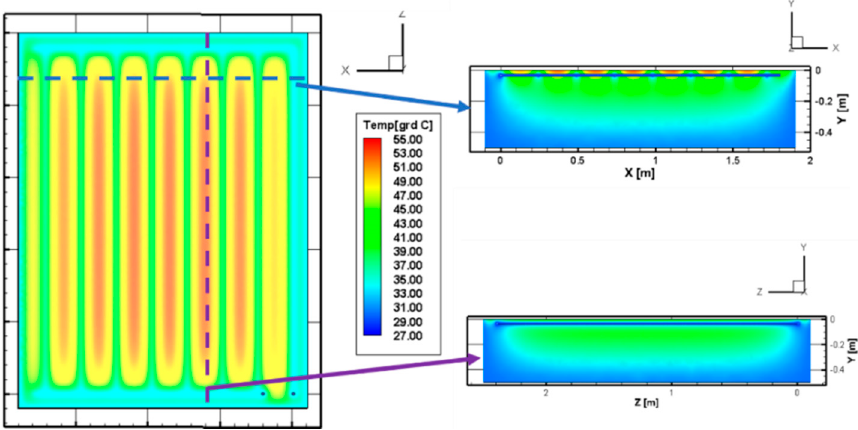
Figure 7. Temperature fields at the external surface and in longitudinal cross-section.